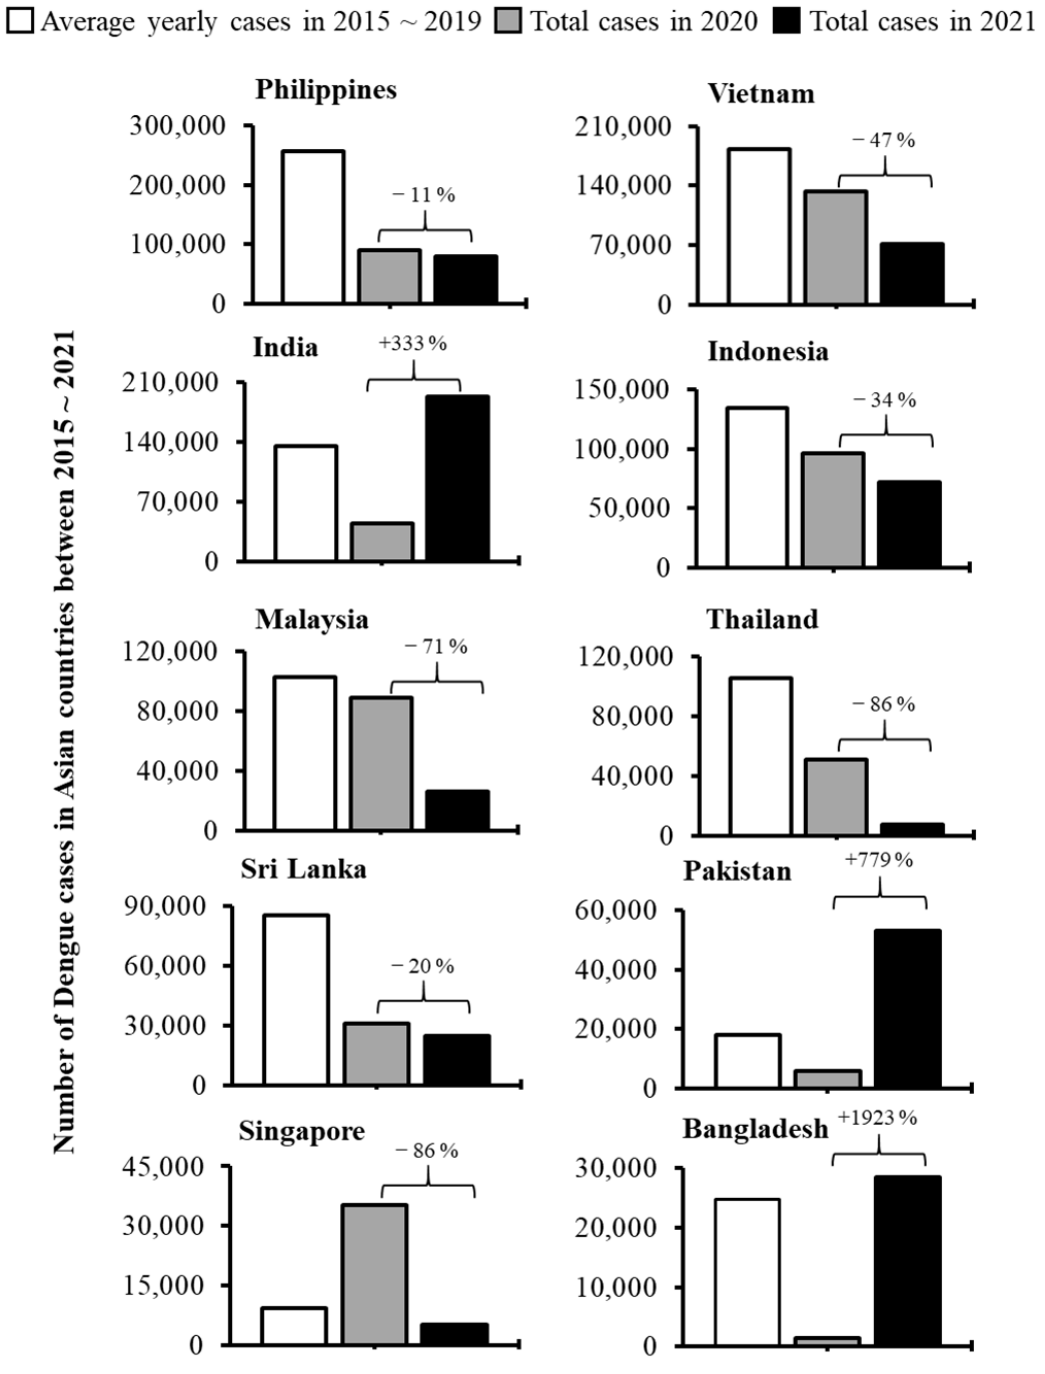
Figure 1. Comparison of dengue incidences in major dengue epidemic countries of Asia between the pre-COVID-19 time (2015~2019) and COVID-19 period (2020~2021).